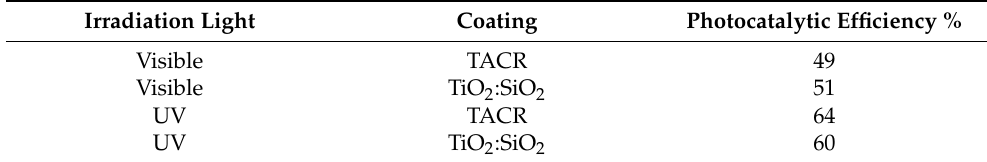
Figure 25. Photocatalytic ceramicized tissue based water purifying reactor according to Fazzani et al. (Reprinted/adapted with permission from Ref. [87]). Table 4. Photocatalytic efficiency of ceramicized tissues with different photocatalytic coatings under visible light and UV irradiation. (Reprinted/adapted with permission from Ref. [87]).